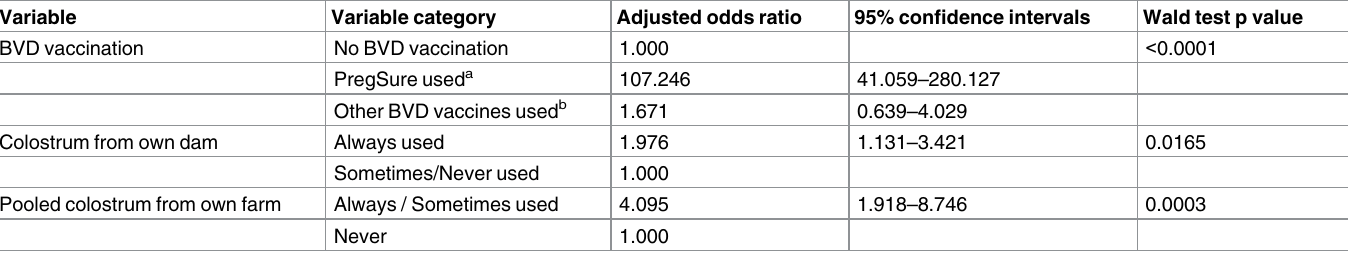
Table 5. Results of the final multivariable conditional model using the variables of the five individual risk groups within a multi-country BNP study (n =